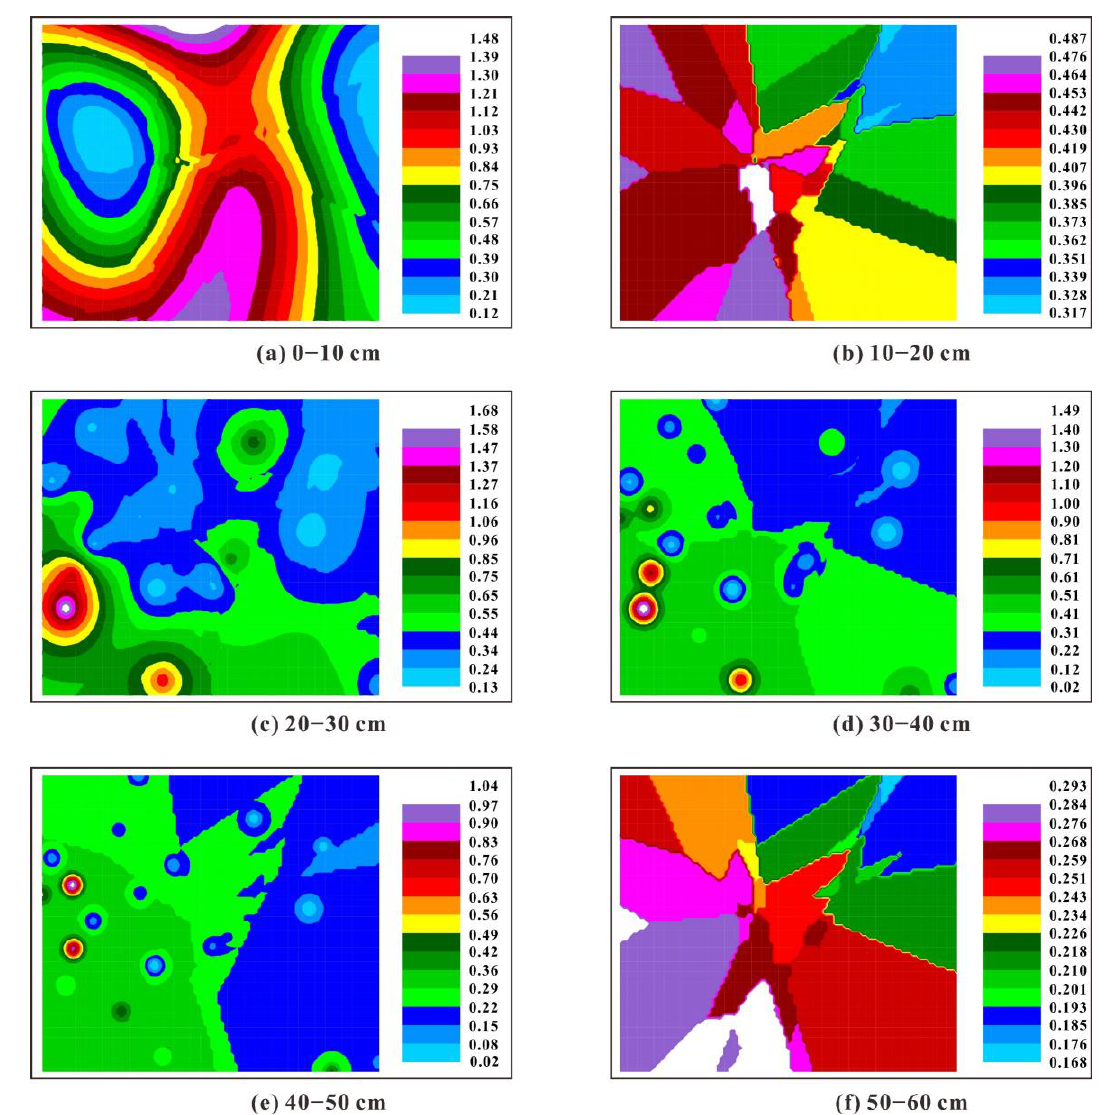
Figure 4. Spatial distribution maps of the Ks (m/day) in the South Dump based on the ordinary kriging interpolation. ( a – f ) represent the soil layers at different depths (0–10 cm, 10–20 cm, 20–30 cm, 30–40 cm, 40–50 cm and 50–60 cm).